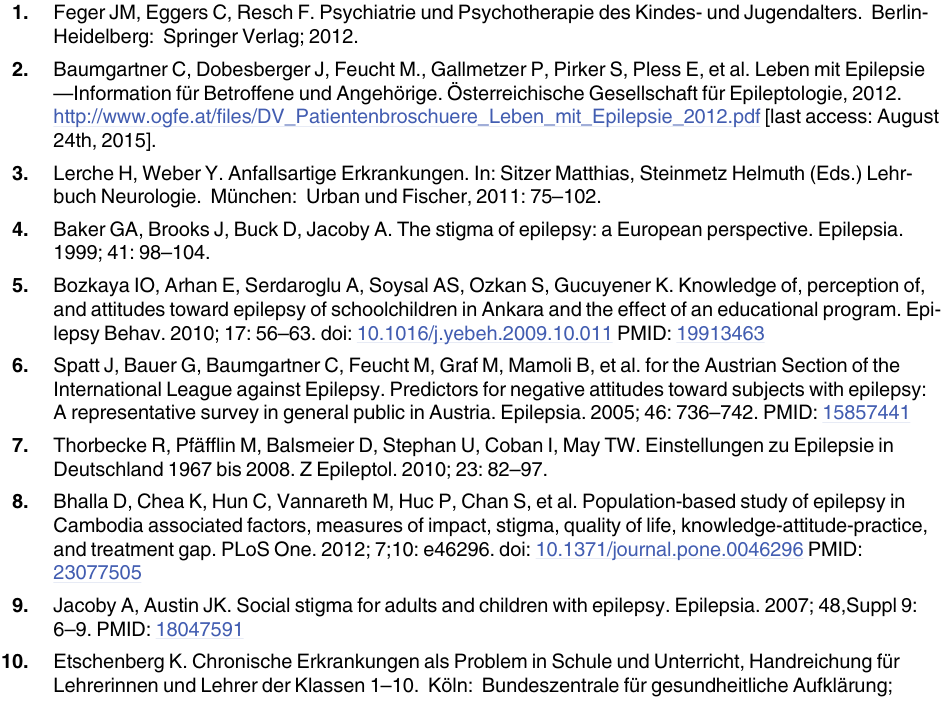
S1 Table. Descriptives for scale scores. CG/TG = control/test group; 1/2/3 = pre-/post-/follow up-test; 1/2/3/4/5 = domains 1 –